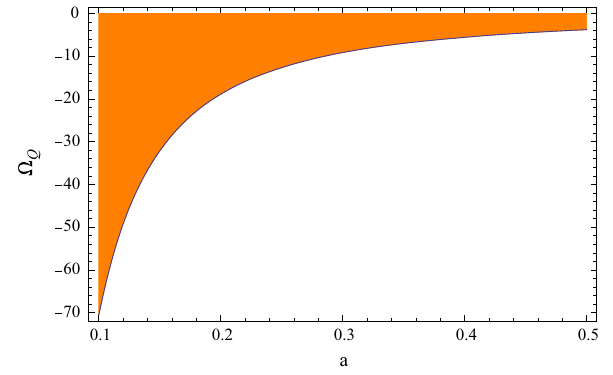
= 0 . 30 and (cid:12) = 0 . 01 0